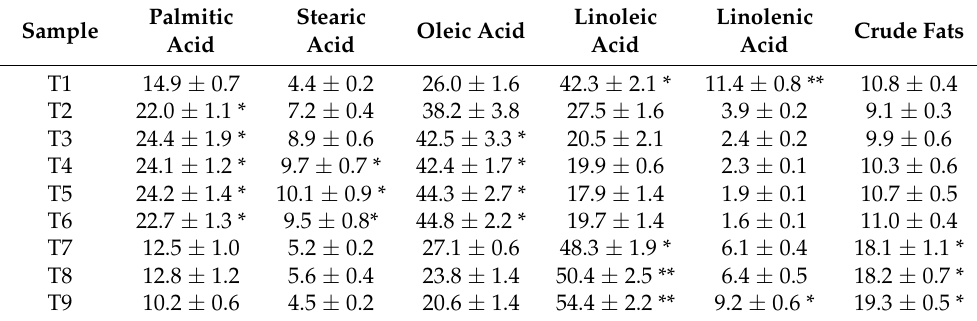
Table 1. The proportion of various fatty acids in the total fatty acids and the contents of crude fats in soybean grains at different stages of maturity. T1–T9 represents the samples of pods collected every 5 days starting from the 35th day after flowering. Symbols “*” and “**” indicate significant differences at p values of 0.05 and 0.01, respectively.